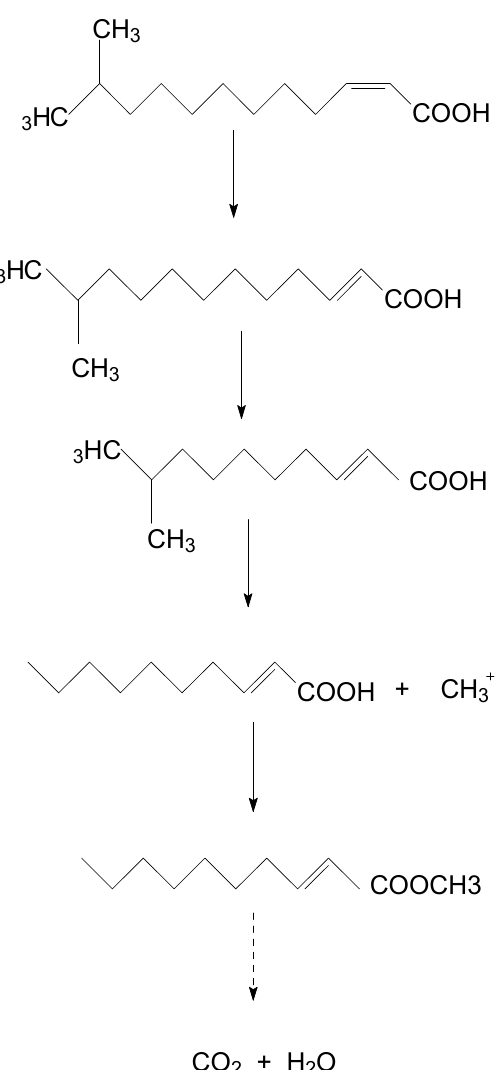
Figure 5. Proposed degradation pathway of DSF in strain HN-2.